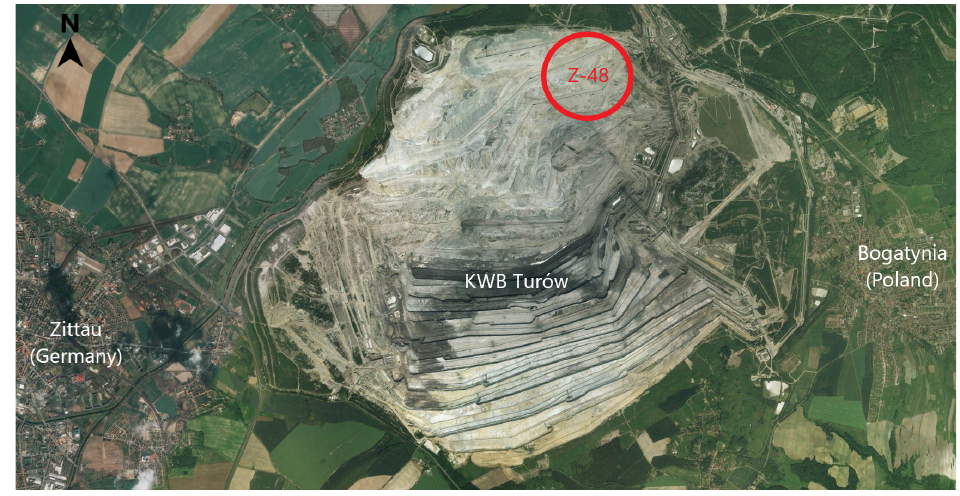
Figure 2 : Operating area of stacker Z-48 in 2019 (Bing